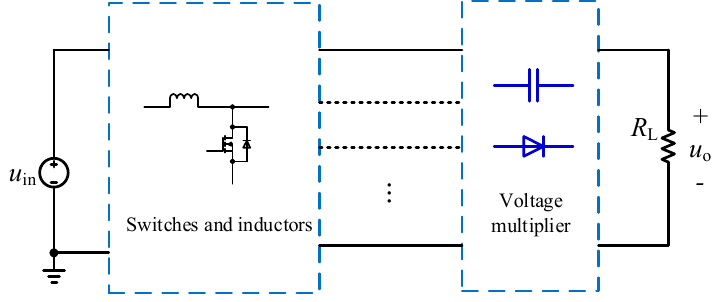
Figure 1. A general circuit for a family of non-isolated high step-up DC / DC converter with capacitor- diode VM.